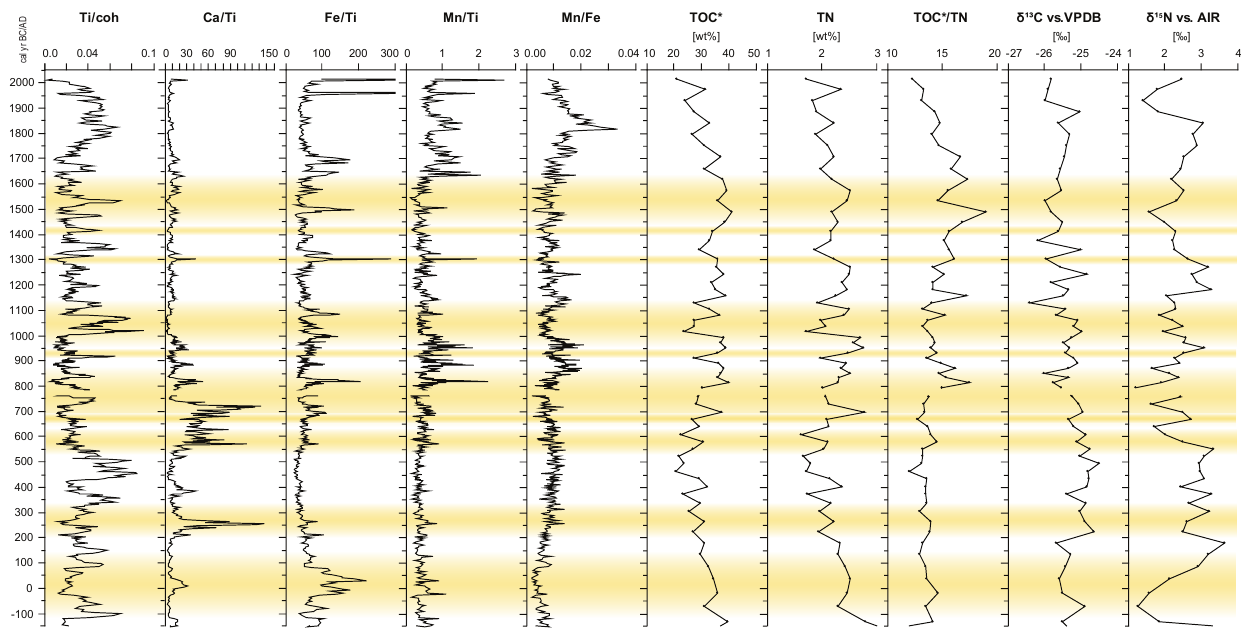
Figure 3. XRF-measured element ratios and elemental and stable isotope contents for core Tuz 694 of Cerro Tuzgle peatland, plotted against age. Yellow bars represent dry